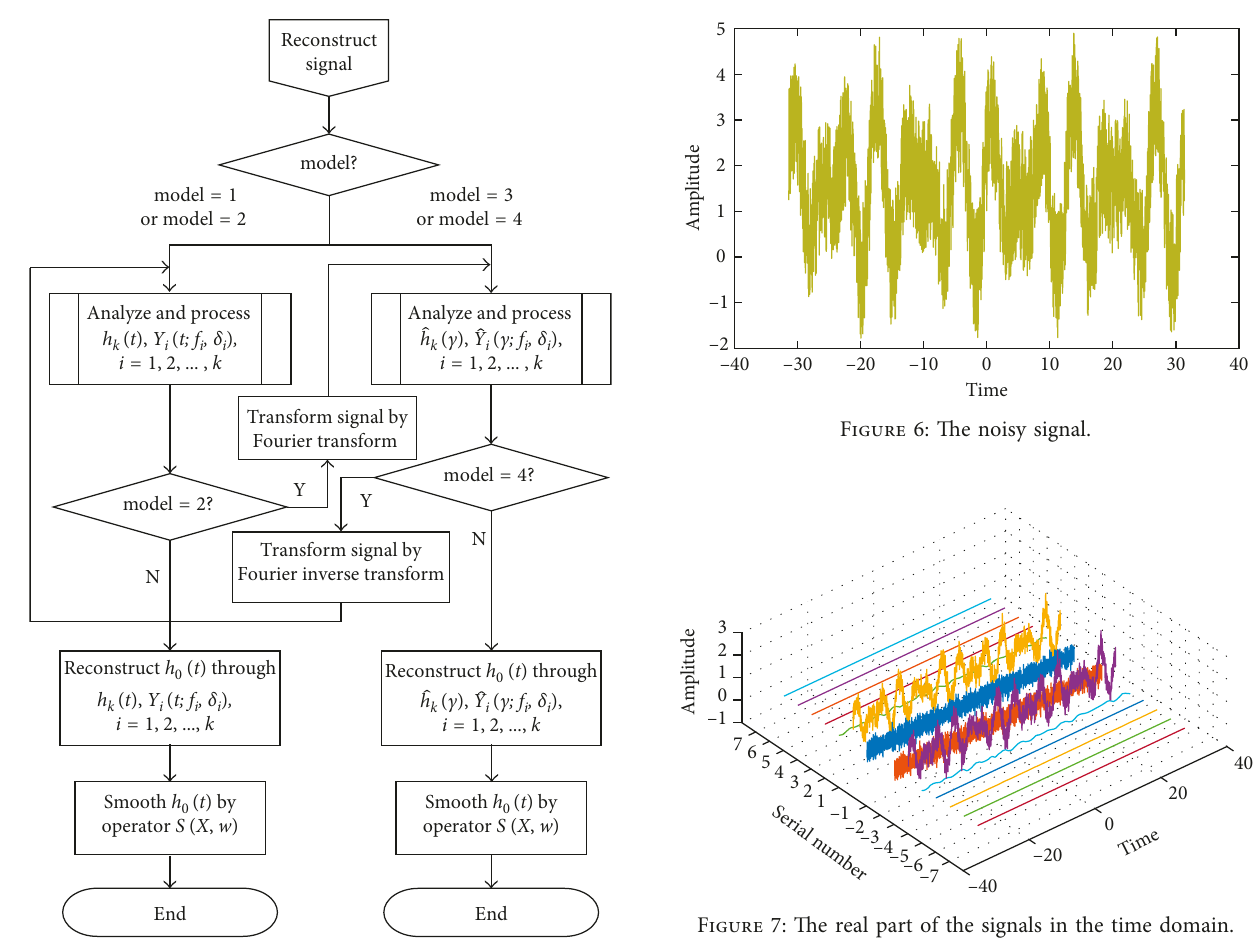
Figure 5: The flow chart for reconstructing a signal.